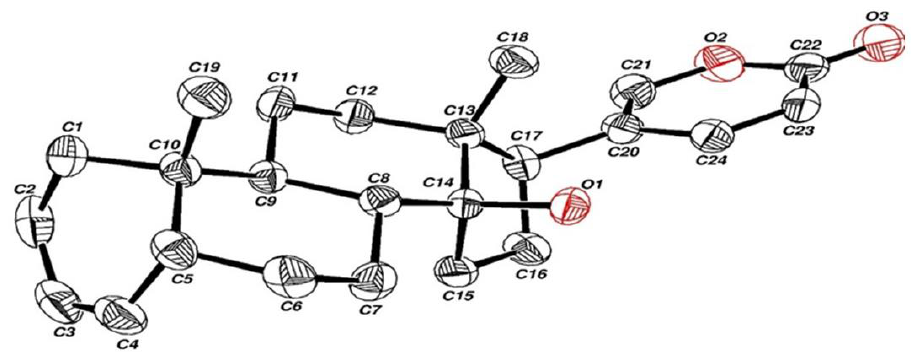
Figure 4. X-ray crystallography of compound 2. After collecting compound 2 (retention time 25 – 26 min in HPLC), the sample was evaporated and the product was crystalized from a 70% acetonitrile/water solution. X-ray crystallography was obtained with an ENRAF-NONIUS CAD-4 computer-controlled diffractometer.